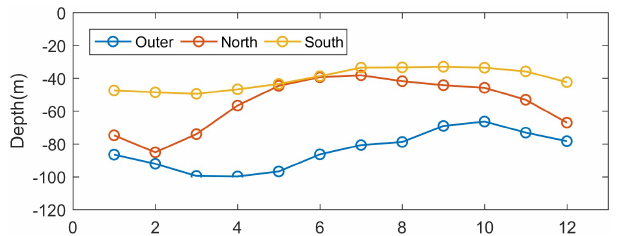
Figure 14. Seasonal evolution of the regionally averaged depth of the thermocline.